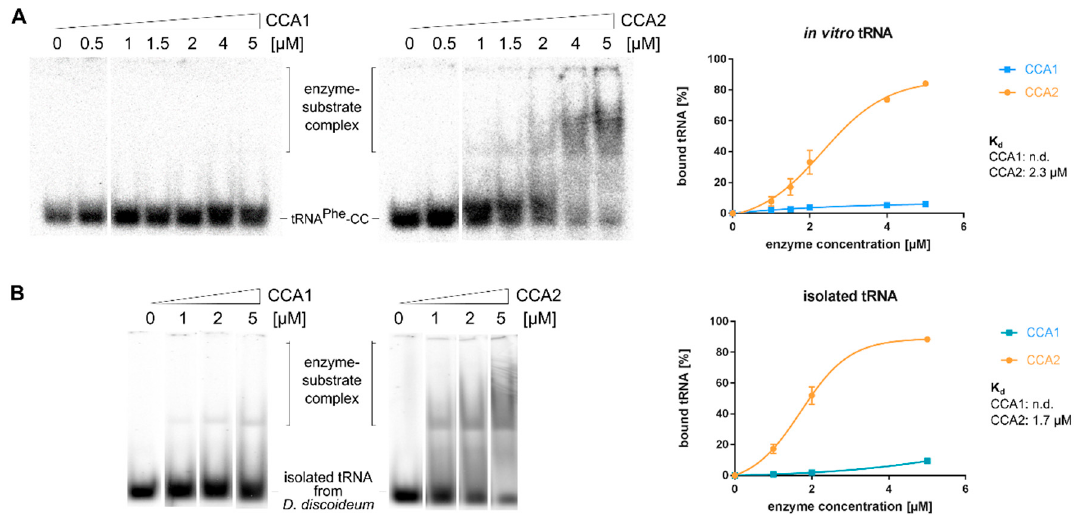
Figure 5. Distinct binding affinities of CCA1 and CCA2. Electrophoretic mobility shifts of CCA1 and CCA2 with in vitro transcribed yeast tRNA-CC ( A ) or total in vivo tRNA of D. discoideum ( B ). Left panel shows representative gel shifts. While CCA1 showed no binding over the whole concentration range (0–5 µM), CCA2 efficiently interacted with its substrates, resulting in clear shift signals. Signals of electrophoretic mobility shift assays (EMSA) were densitometrically quantified and used for determination of binding constants (right panel). For CCA2, binding constants of 1.7 µM (in vivo tRNA) and 2.3 µM (in vitro tRNA) were determined, while CCA1 interaction is too weak to allow for a calculation of its substrate affinity.